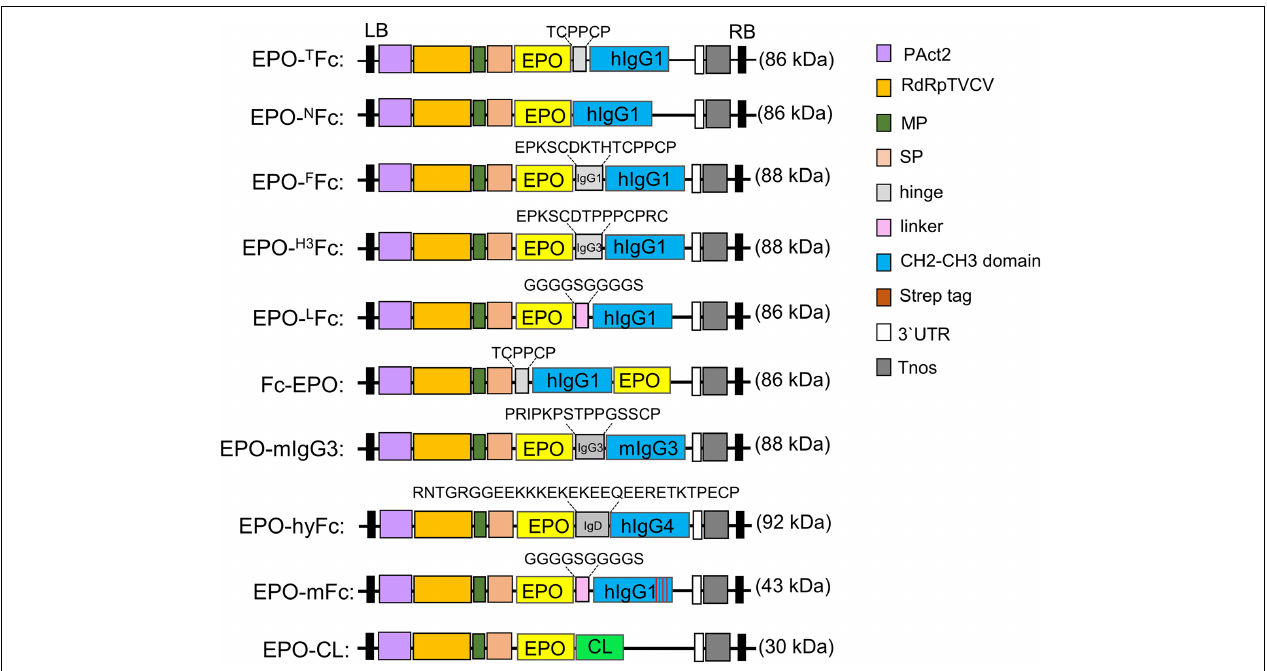
FIGURE 1 | Schematic representation of the expression vectors used in this investigation.The modified TMV-based MagnICON vector (pICH α 26211 α ) with a targeting sequence for the secretory pathway was used to clone the fusion proteins. Common features are: PAct2: Arabidopsis actin 2 promoter; RdRpTVCV, RNA-dependent RNA polymerase from Turnip vein clearing virus; MP, movement protein from the tobacco mosaic virus; SP, barley α -amylase signal peptide for apoplast targeting. Tnos, nopalin synthase gene terminator; 3 (cid:48) UTR, TVCV Pol. 3 (cid:48) -untranslated region; LB, left border; RB, right border; EPO, human erythropoietin; CL, constant domain of IgG1 light chain. The calculated protein molecular weight is shown for each native fusion (for full peptide sequence, see also Supplementary Figure 1